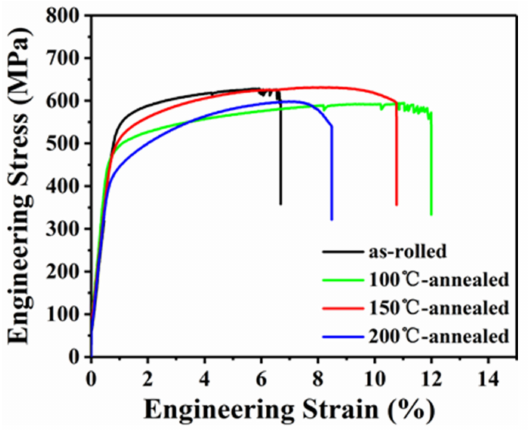
Figure 7. Tensile engineering stress–strain curves of as-rolled and as-annealed Al-10.0Mg-1.0Zn- 0.15Cu (wt%) alloy. Table 2. Tensile properties of as-rolled and as-annealed Al-10.0Mg-1.0Zn-0.15Cu (wt%) alloys.